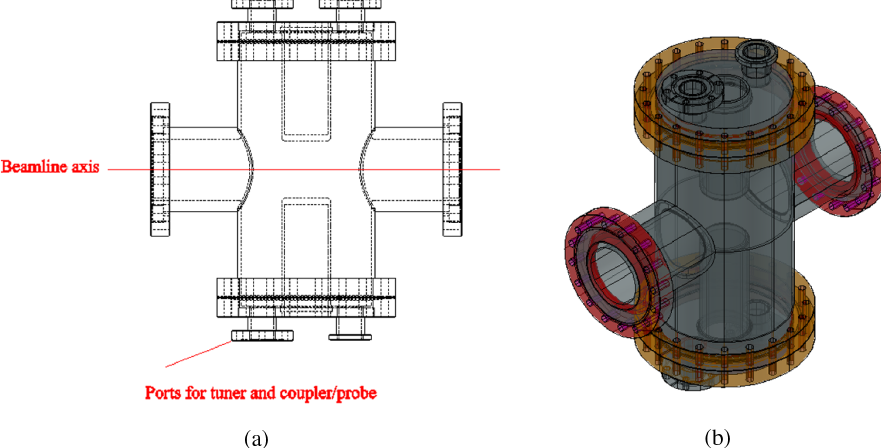
FIG. 3. (a) Schematic of DQWR cavity with beam axis and ports indicated. (b) Transparent 3D drawing of DQWR